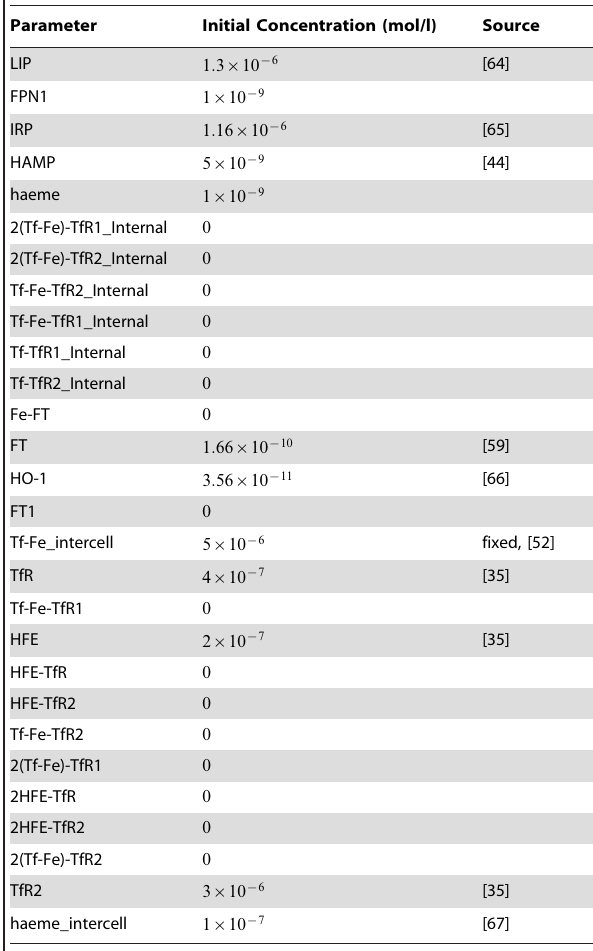
Table 2. Initial conditions.